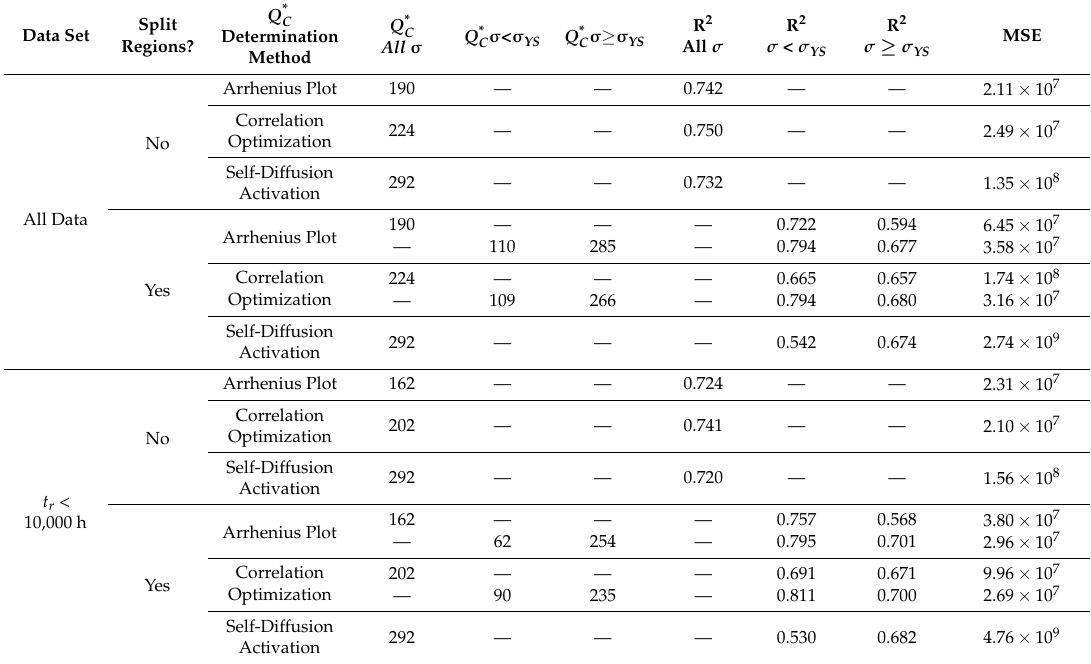
Table 5. Quality of fit and error for Inconel 617.